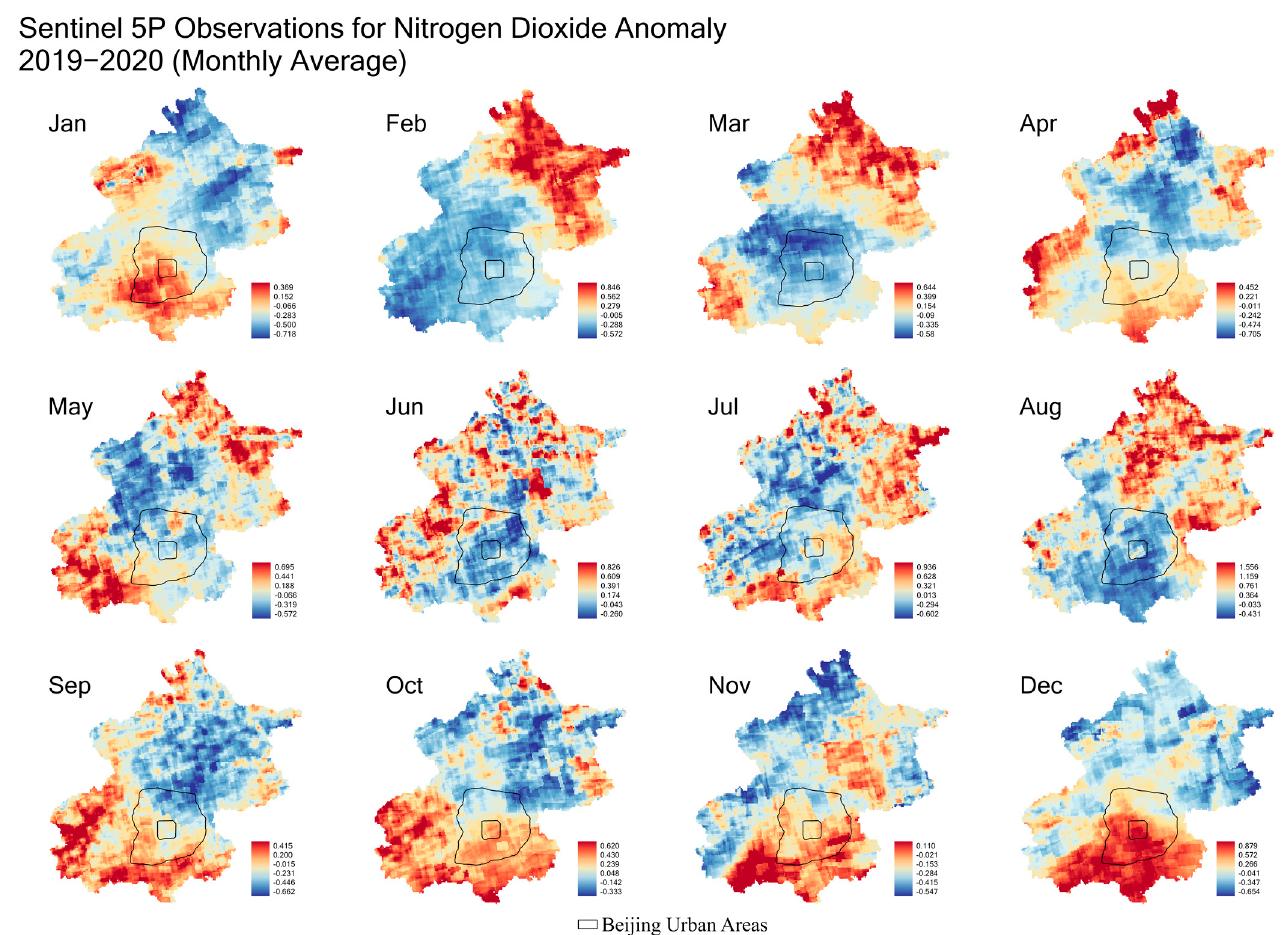
Figure 6. Changes in NO 2 levels comparing the years 2019 and 2020, using the monthly average data of tropospheric NO 2 column number density (mol/m 2 ) from Sentinel 5P. The changes or differences are calculated by taking 2020 levels minus the same period in 2019. The satellite observation data show the spatial heterogeneity (different spatial distributions) of NO 2 levels at 1 km spatial resolution. From August to December 2020, NO 2 in some places increased but declined in other places, which is evident from the remote sensing data but is not reflected in the average aggregated data from the ground monitor. For example, the line graphs of NO 2 levels mea- sured with ground-station data show that there was a NO 2 rebound anomaly in November 2020, which was higher than the expected results, while the remote sensing data showed where the spatial differences were. This may indicate that some conditional economic recovery activity (coexistence with the pandemic mode) led to the spatial heterogeneity of production